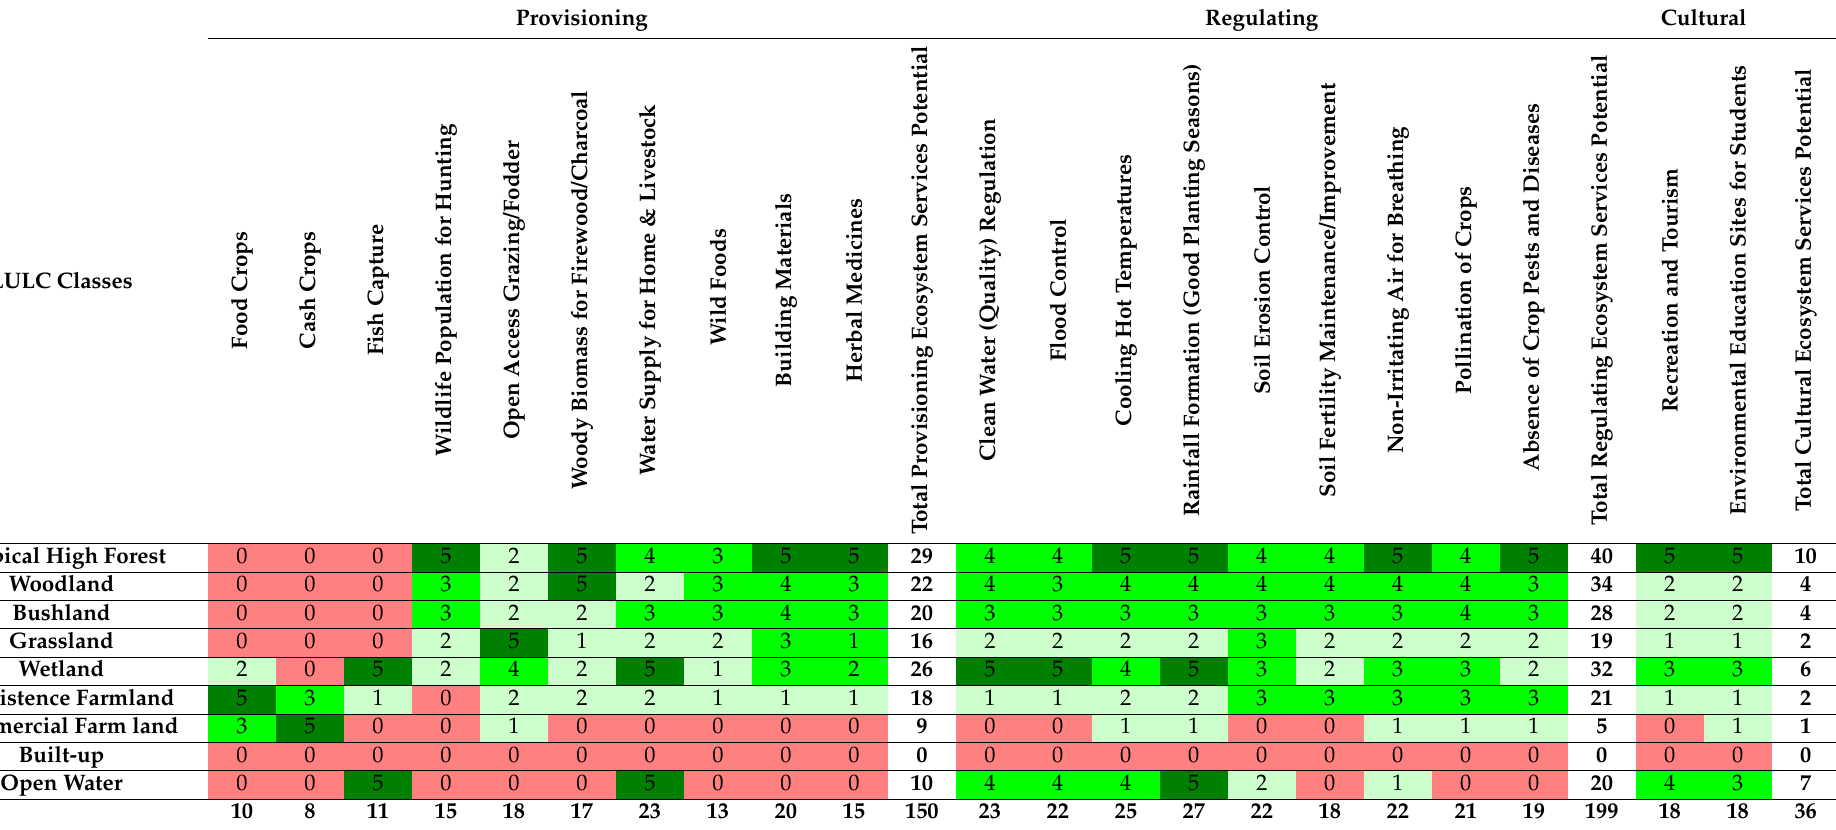
Table 3. Ecosystem service matrix for different LULC classes in Budongo–Bugoma